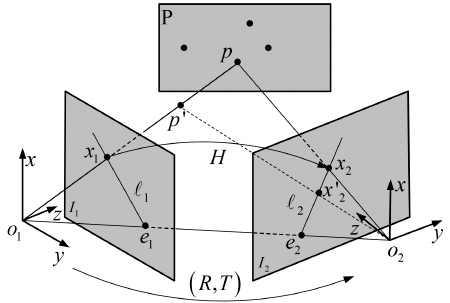
Figure 4. The schematic diagram of the epipolar constraint.